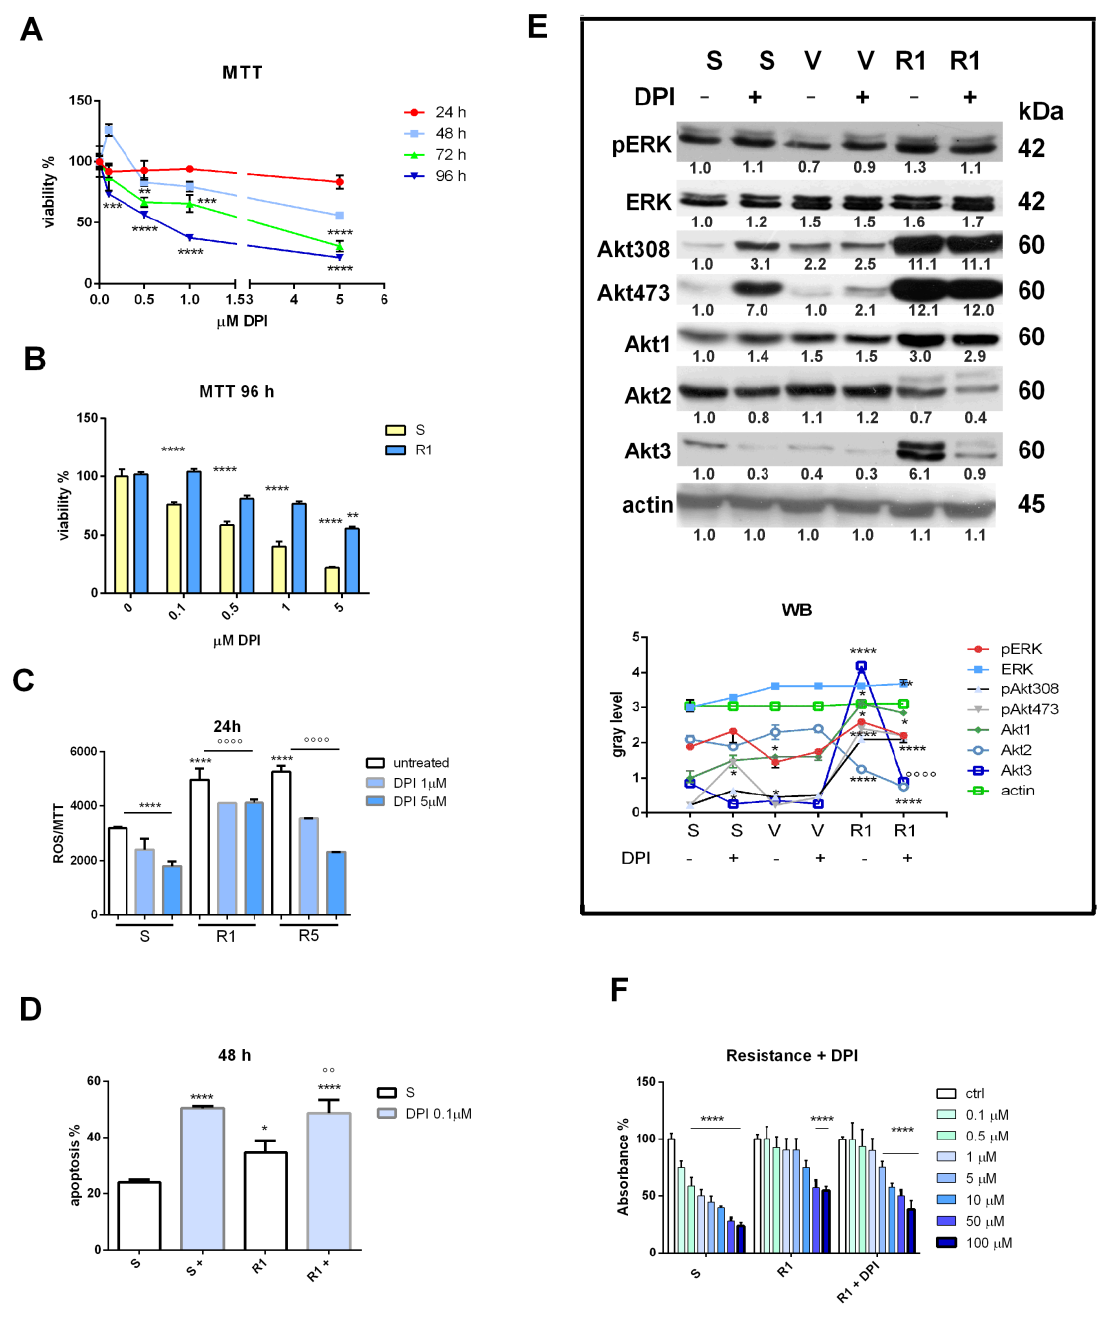
Figure 2. Effect of Nox inhibition on melanoma cells induced or not induced to drug resistance. ( A ) Graph showing viability test with MTT assay measured in SK-MEL-28 cells exposed to increasing concentrations of DPI for 24 to 96 h. ** p -value < 0.01; *** p -value < 0.001; **** p -value < 0.0001. ( B ) Graph showing viability test with MTT assay measured in SK-MEL-28 cells induced or not induced to resistance, with method 1 (R1) exposed to increasing concentrations of DPI for 96 h. ** p -value < 0.01; **** p -value < 0.0001 ( C ) Graph showing ROS levels normalized to MTT values measured in SK-MEL-28 cells S, R1, and R5 treated with DPI (+) up to 1 or 5 µM for 24 h. ****, °°°° p -value < 0.0001. ( D ) Graph showing apoptosis induction with MUSE assay measured in SK-MEL-28 cells (sensitive (S) or R1) treated with DPI 0.1 µM for 48 h; * p -value < 0.05; °° p -value < 0.01; **** p -value < 0.0001. ( E ) Western blot analysis of total lysate of S, treated with vemurafenib for 48 h (V), and R1 SK-MEL- 28 cells, treated or not treated with 0.1 µM DPI for 24 h, revealed with anti- p -ERK (V * p -value < 0.05; R1 p -value < 0.05), anti-ERK, anti-p-Akt308 (S+ ** p -value < 0.01; V and V+ p -value < 0.05; R1 and R1+ **** p -value < 0.0001), anti-p-Akt473 (S+ p -value < 0.01; V+ p -value < 0.05; R1 and R1+ p -value < 0.0001), anti-Akt1 (R1 and R1+ p -value < 0.05), anti-Akt2 (R1 p -value < 0.05; R1+ p -value < 0.01; R1 vs. R1+ p - value < 0.01), anti-Akt3 (S+, V, V+, R1+ p -value < 0.05; R1 p -value < 0.0001; °°°°R1 vs. R1+ p -value <